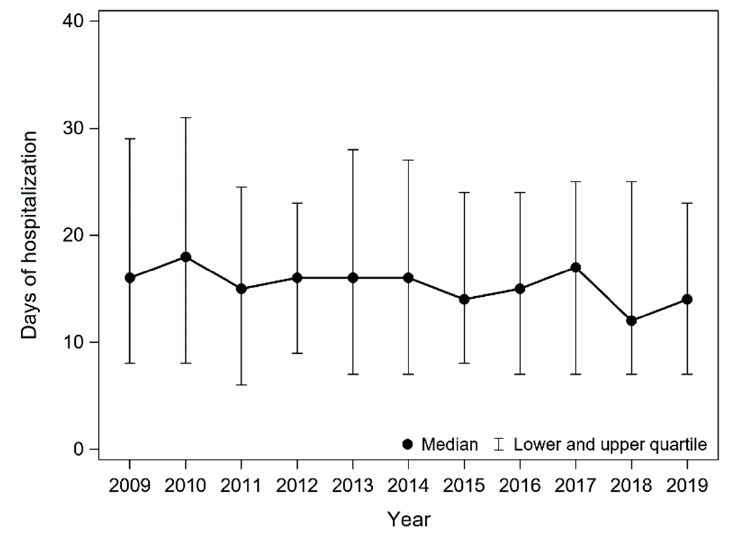
Figure 3. Median hospitalization time (from admission to the first ward to final discharge) for SAH patients in the Silesian Province between 2009 and 2019.